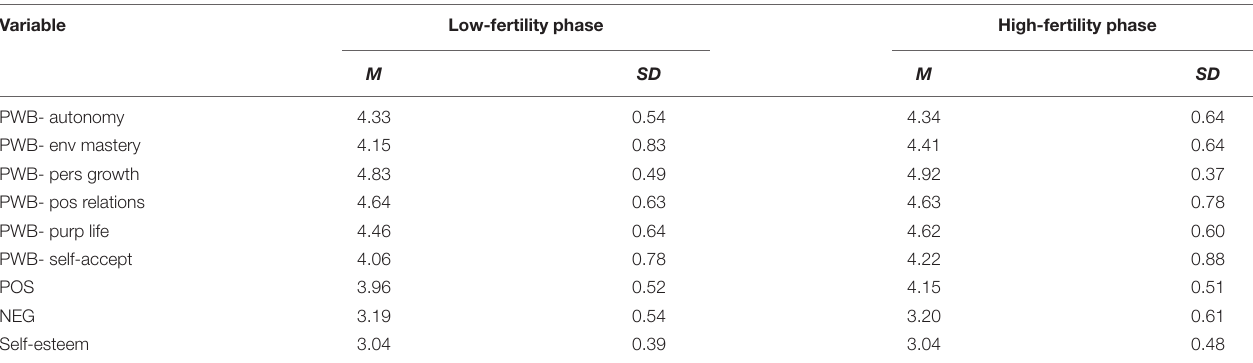
TABLE 2 | Means and standard deviations of dependent